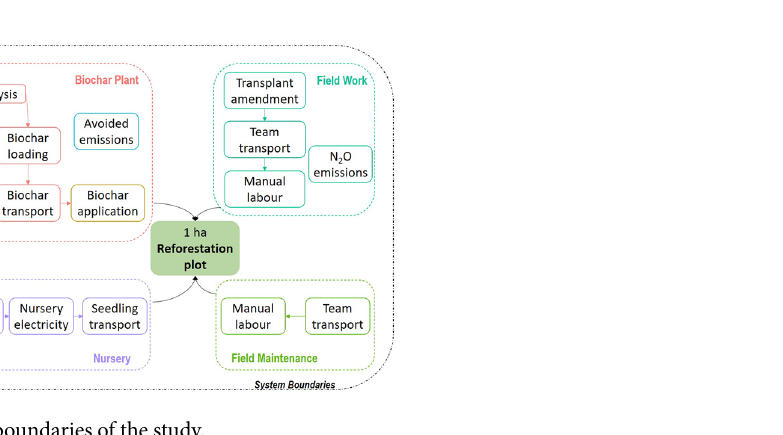
Figure 2. Case study location. Generated using Google Earth Pro (version 7.3.4.8248) 22 .